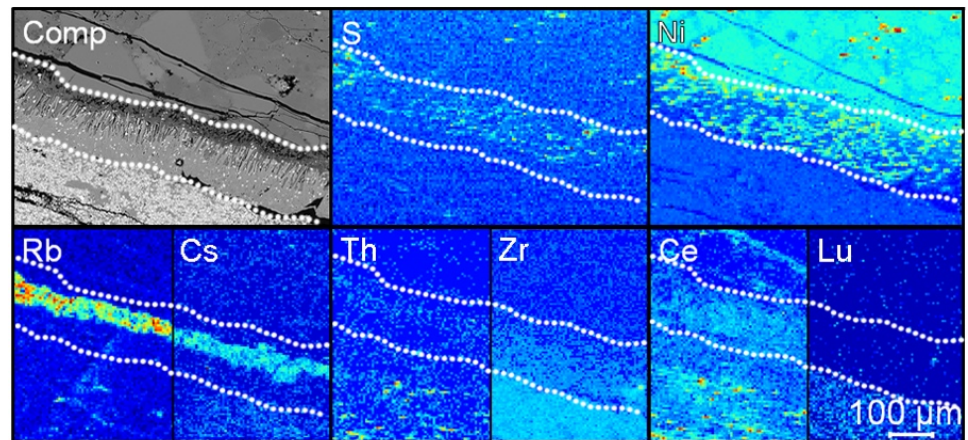
Figure 3. Trace element maps recorded by LA-ICP-TOFMS show the distribution of S, Ni, Rb, Cs, Th, Zr, Ce, and Lu in relation to the mineralogy shown in the backscattered electron (Comp) image. Rb, Cs, and S are enriched in the reaction zone in phlogopite and sulphides. The sulphides also host Ni, explaining its heterogeneous occurrence inside the reaction zone. Th, Zr, and Ce are present within the reaction zone, while Lu is confined to the residue of the former sediment.